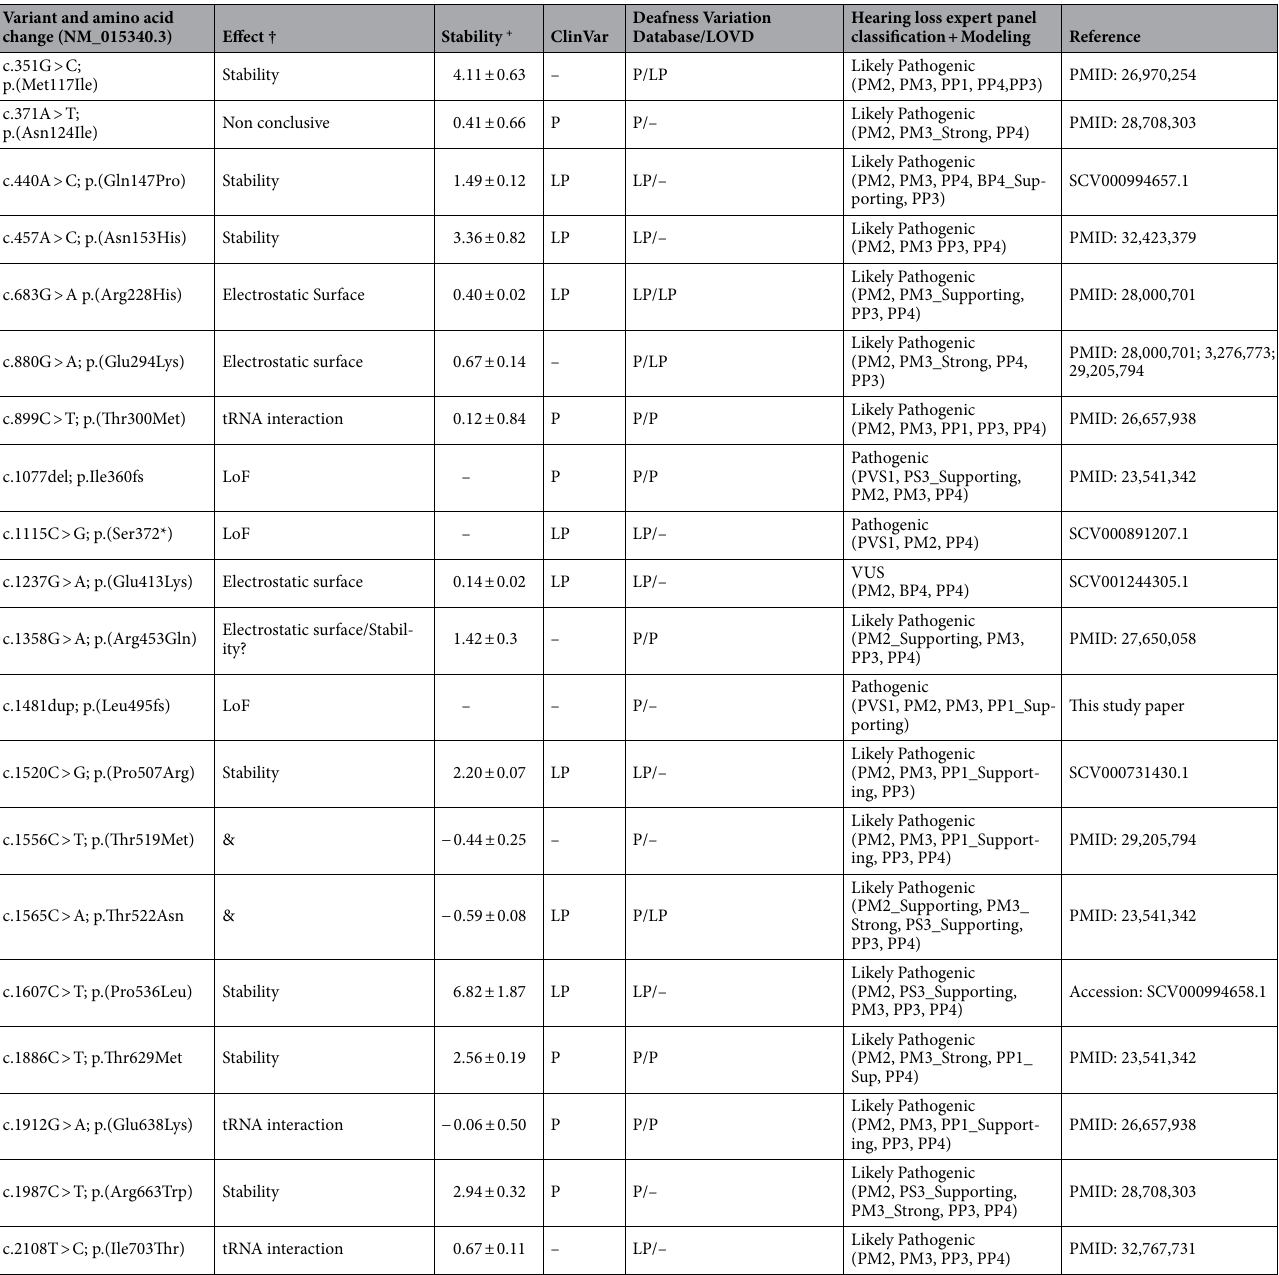
Table.3. Evaluation of genetic variants in LeuRS. † Classification of variants according to